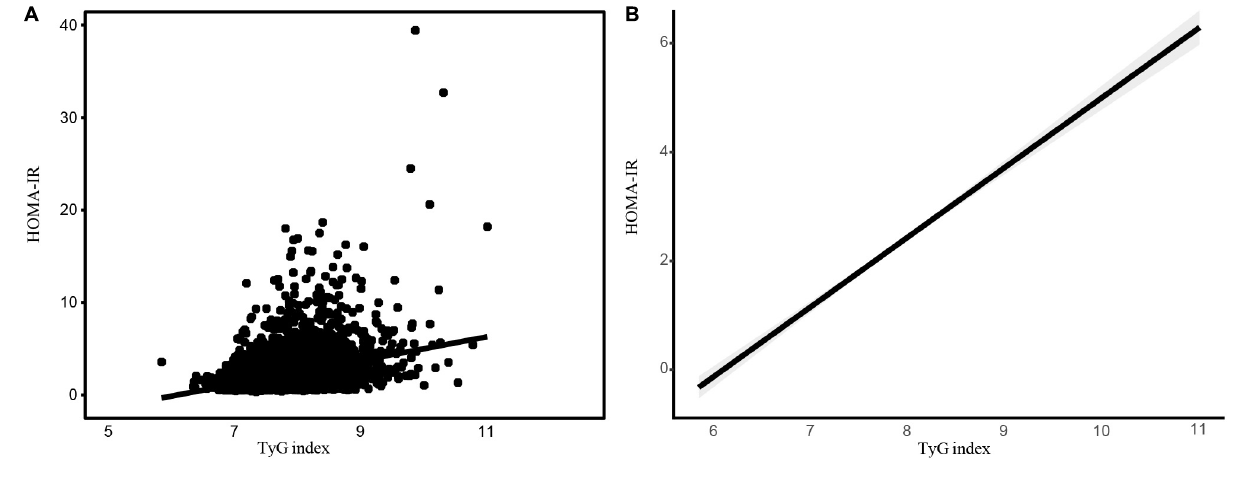
FIGURE 1 | The association between the TyG index and HOMA-IR. The association between the TyG index and HOMA-IR. (A) Each black point represents a sample. (B) A solid black line represents the smooth curve fit between variables. The gray area represents the 95% of confidence interval (CI) from the fit. Abbreviations: TyG, Triglyceride-glucose; HOMA-IR, homeostasis model assessment-insulin